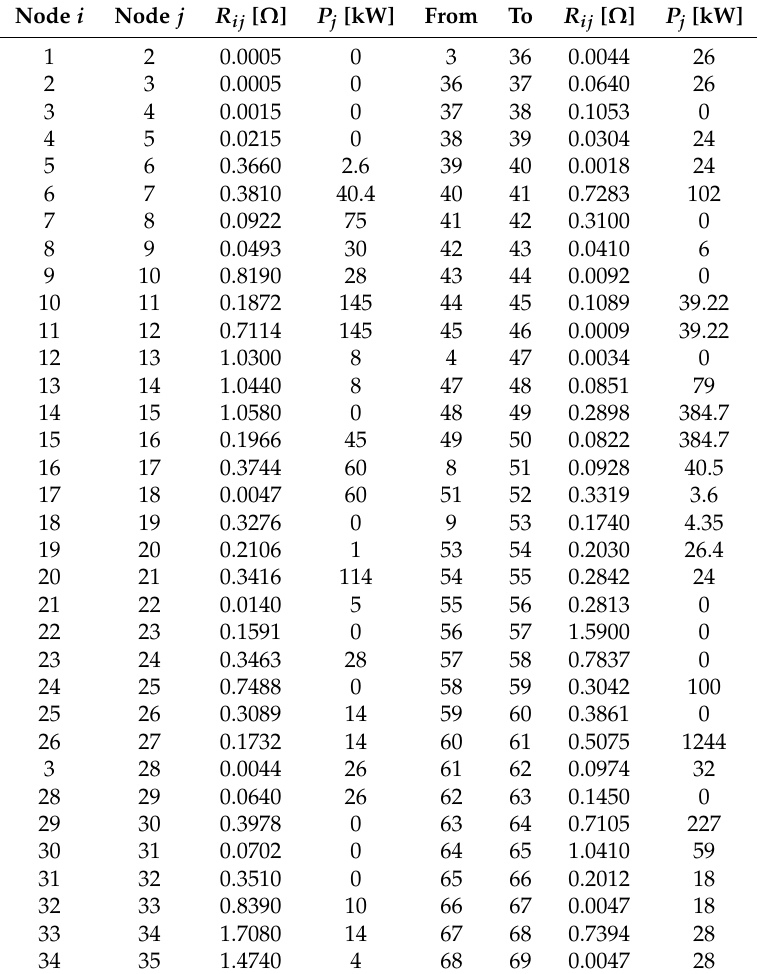
Table 2. Parametric information of the 69-node test